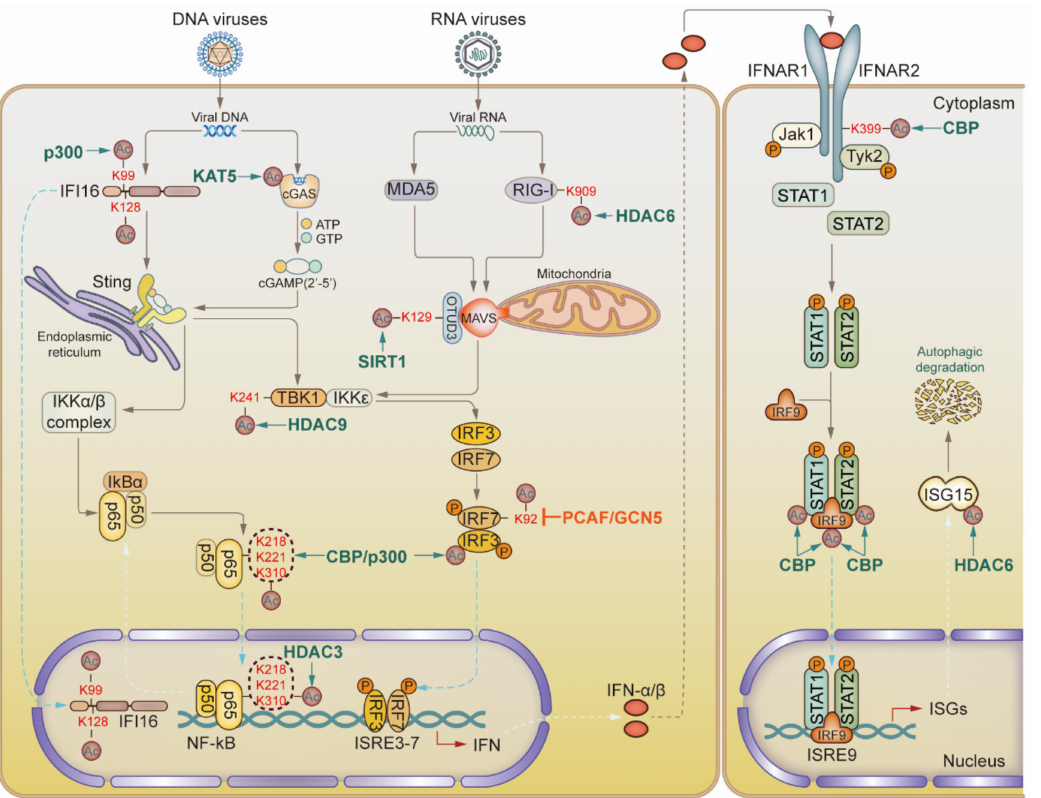
Figure 1. Acetylation modulates key factors of type I interferon (IFN) pathway during viral infection. In the upstream IFN signaling pathway, molecules such as cGAS, RIG-I, MAVS, IRF3, IRF7, and NF- κ B, can be acetylated or deacetylated by specific acetyltransferases or deacetylases, modulating the production of IFN. In the downstream IFN signaling pathway, CBP can acetylate IFNAR2, STAT1, and STAT2, facilitating transcriptional activation of interferon-stimulated